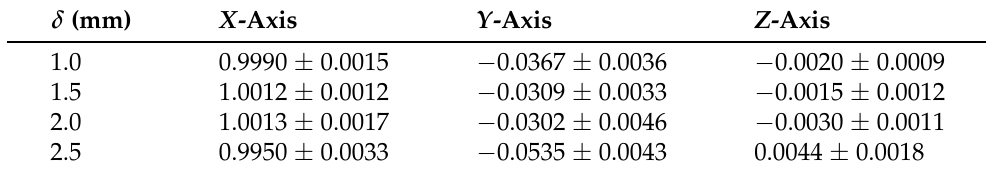
Table 3. Statistical results of the acceleration values (g).